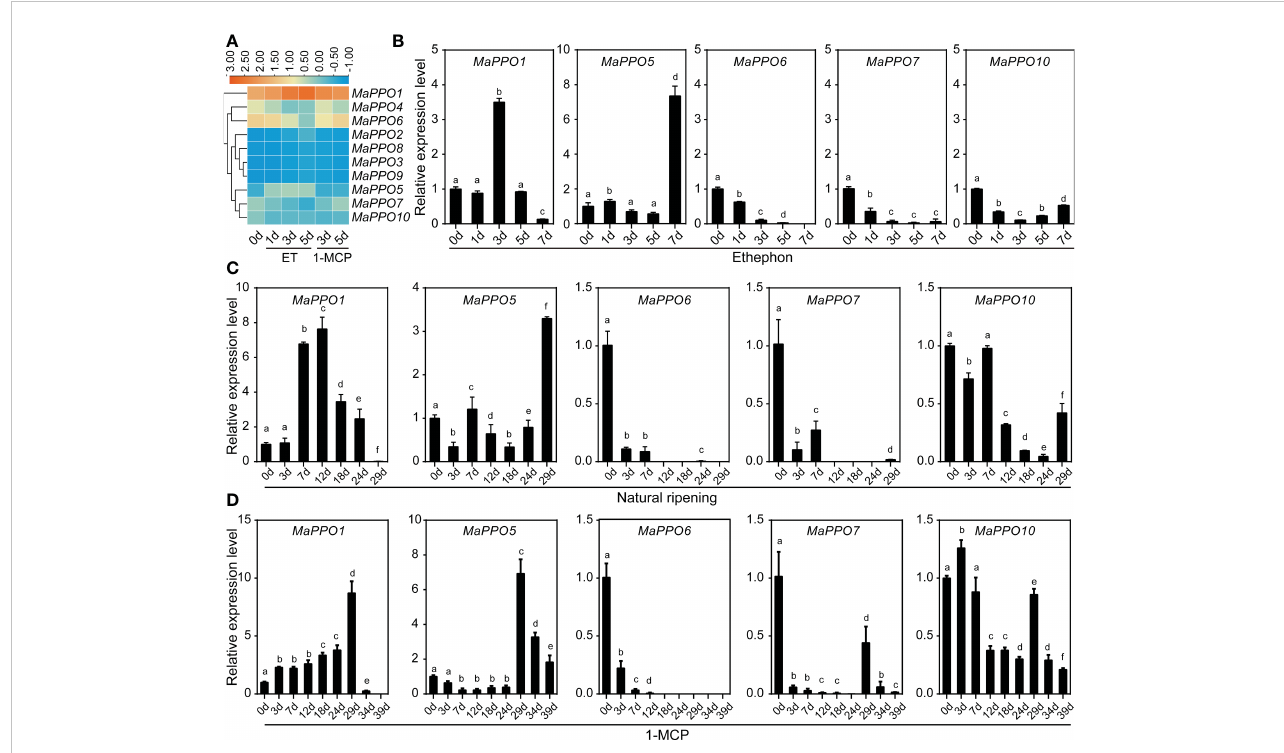
FIGURE 6 Expression pro fi le of MaPPO genes in banana under different treatments. (A) Heatmaps showing the expression levels of 10 MaPPO genes in response to ethephon and 1-MCP. (B – D) Determination of the expression level of MaPPO genes under ethephon treatment (B) , natural conditions (C) , and 1-MCP treatment (D) . Different letters indicate signi fi cant differences (P < 0.05) examined by one-way ANOVA.